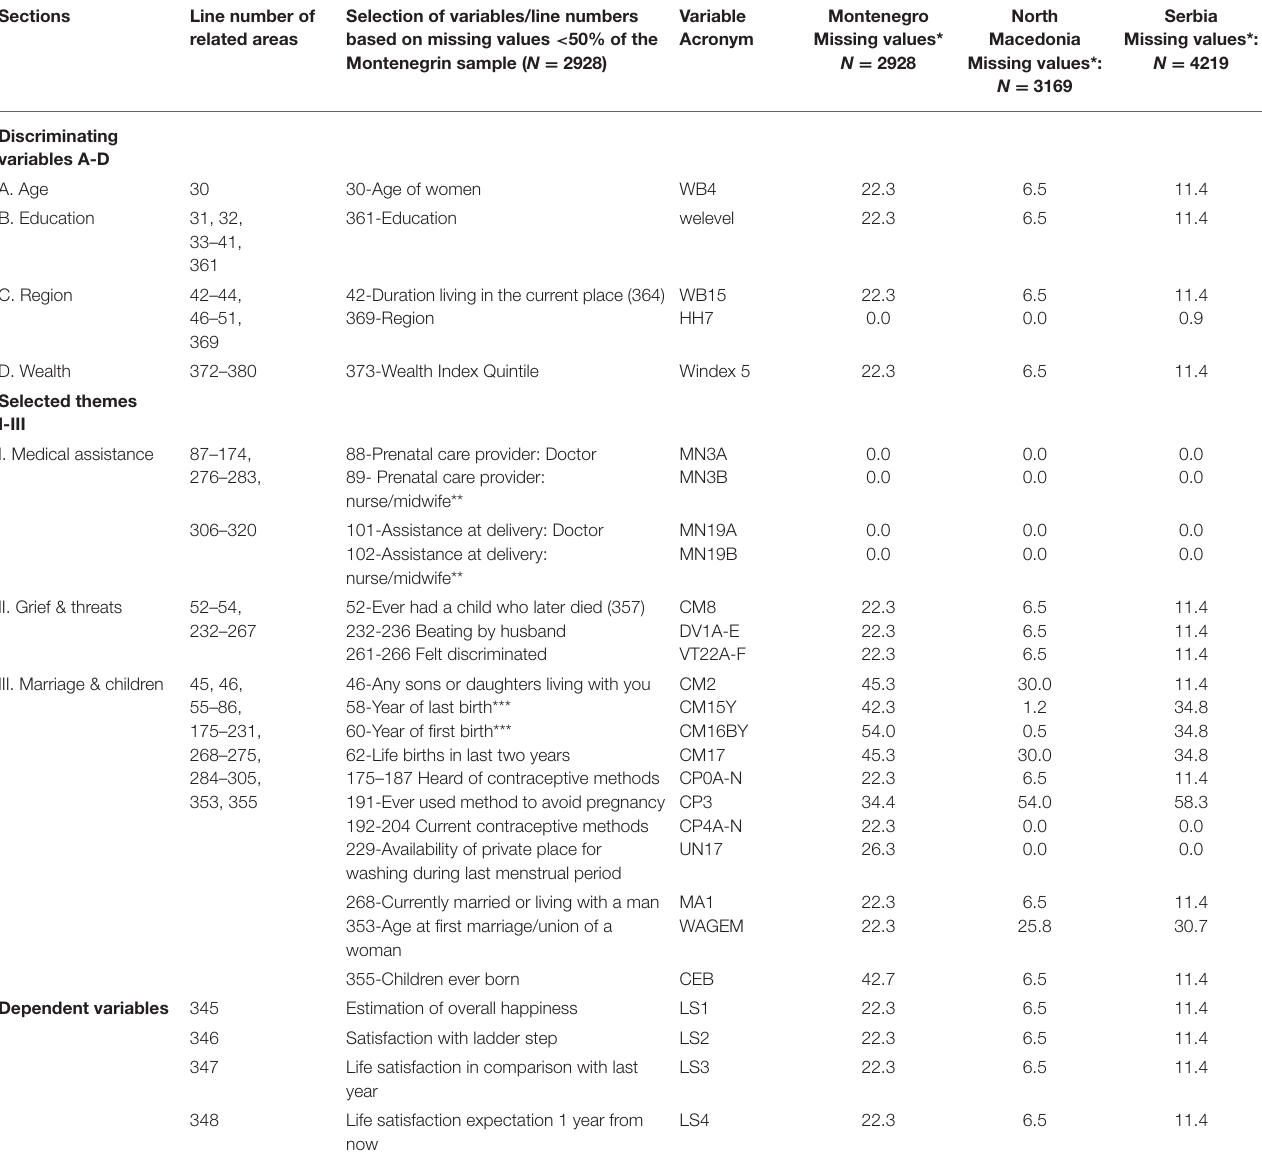
TABLE 1 | Selection of variables with missing values. Sections Line number of